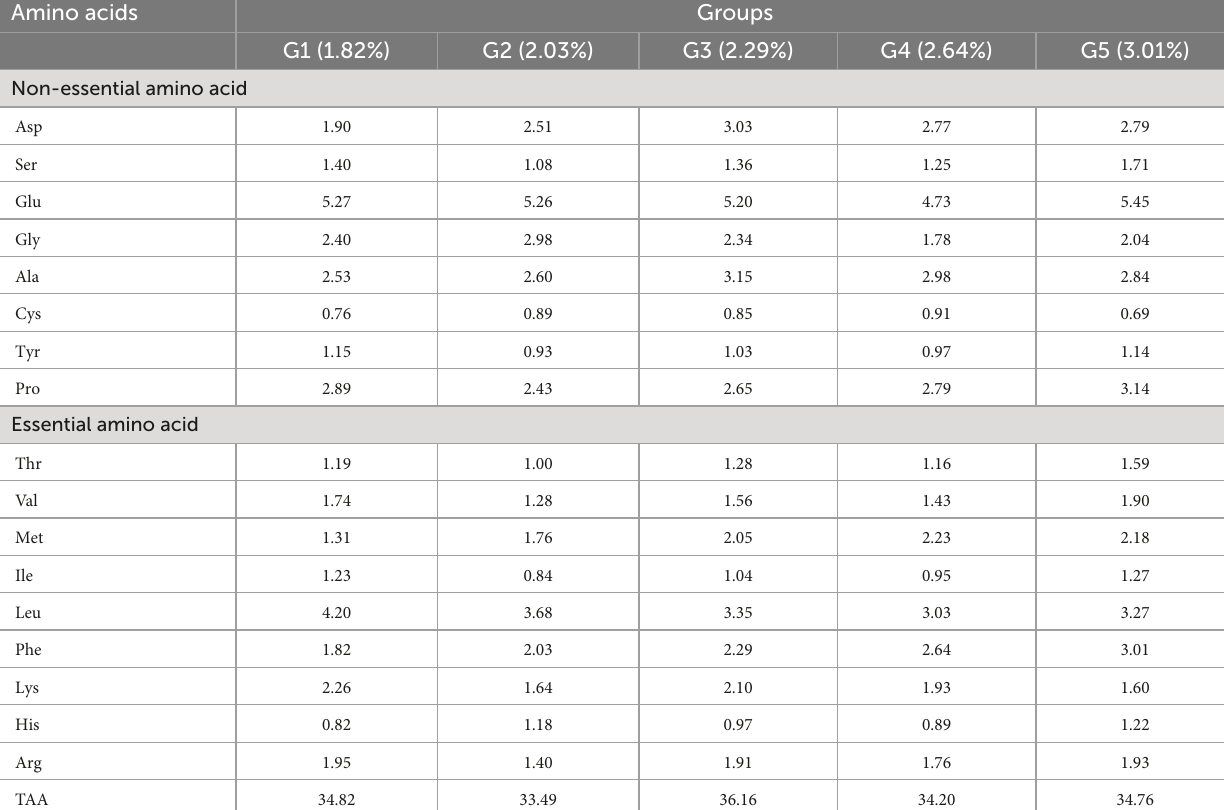
TABLE 2 Amino acids composition of the basal diets (air-dry basis, %). Amino acids